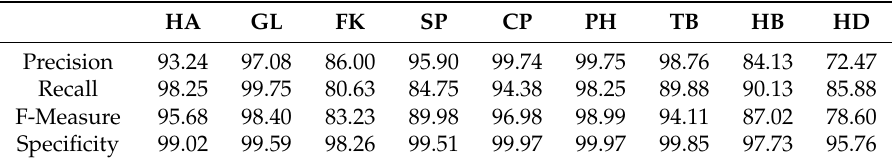
Table A5. Values of precision, recall, F-Measure, specificity of LOSO model SVM IWT (all values are expressed in